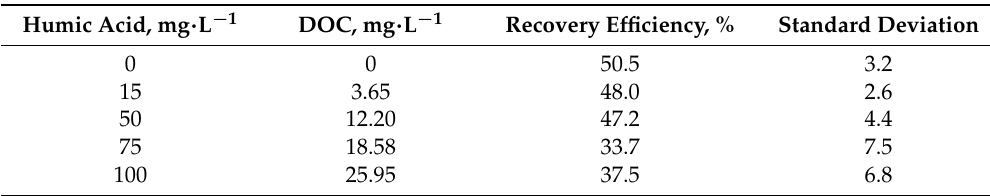
Table 2. Recovery efficiency values for different HA concentrations. Source solution: 1 mg · L − 1 Ni 2+ ,